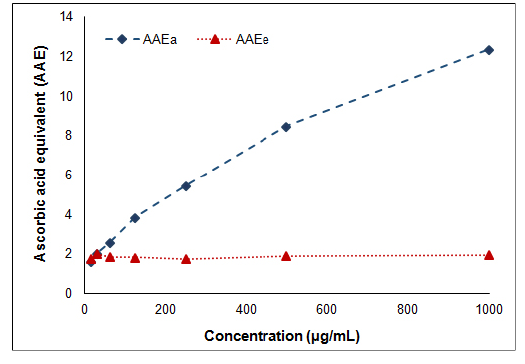
Fig. 2. Percentage DPPHº inhibition of aqueous and ethanol extracts of D. sarmentosa leaves.